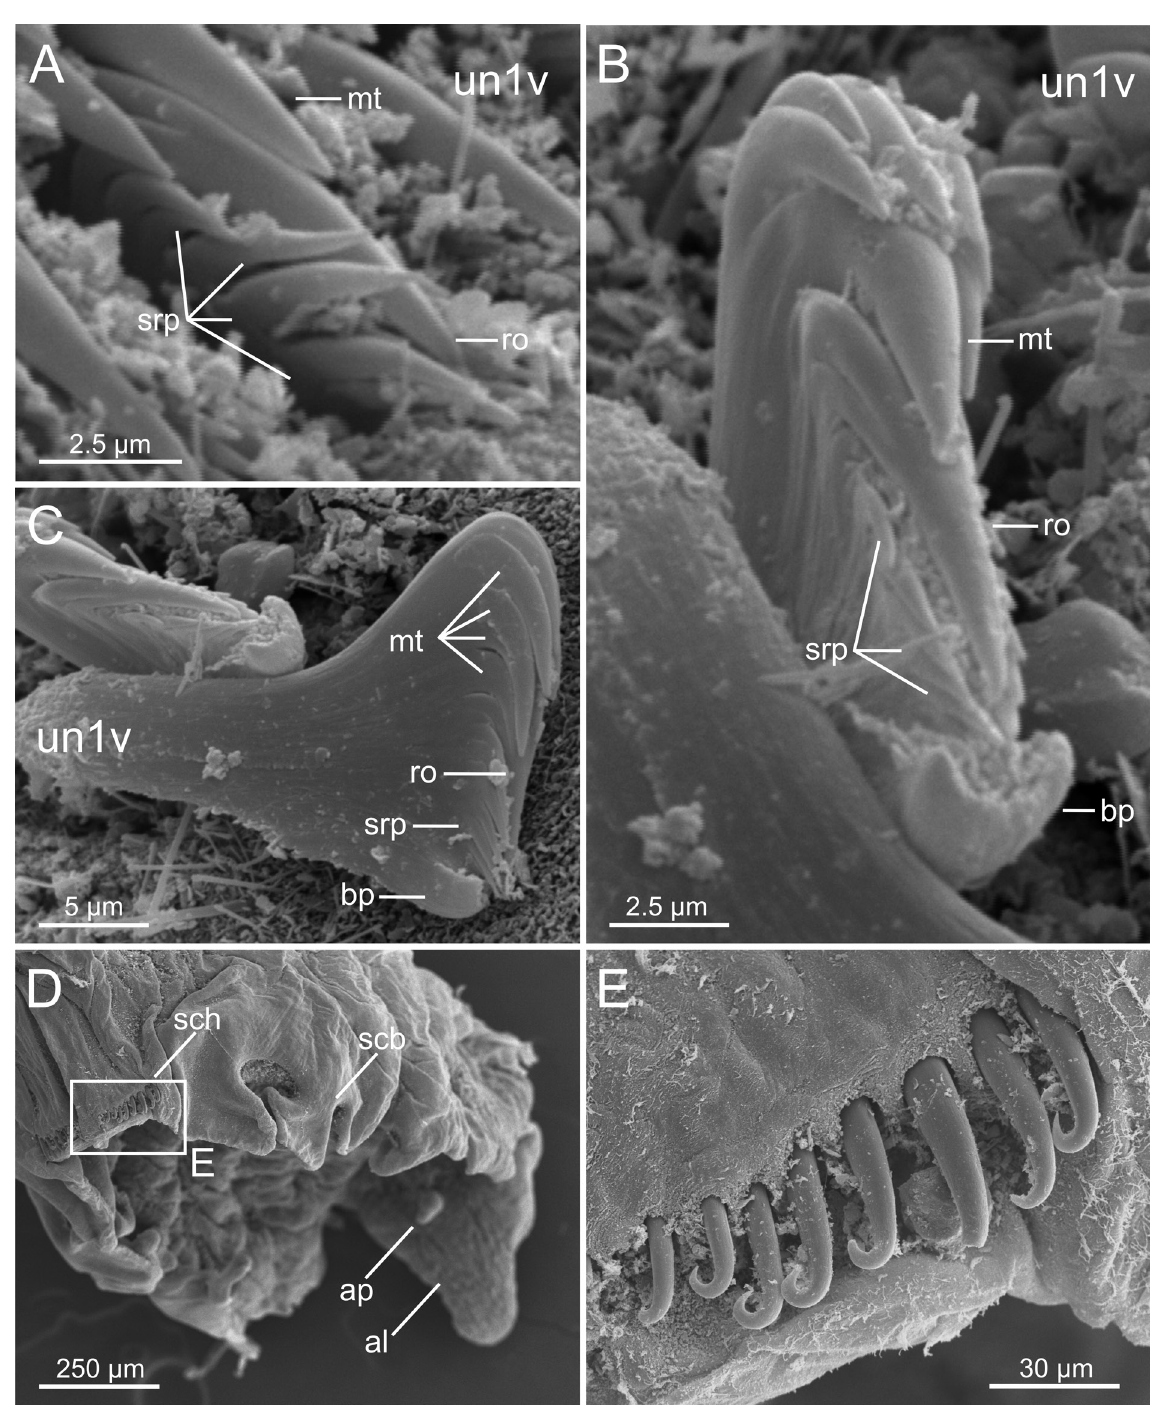
Fig. 6. Amphictene auricoma (O.F. Müller, 1776). SEM micrographs from a large specimen (BIOICE sample 2998, IINH-40213). A–C . Unciniger 1, ventral uncinus, frontolateral, frontal and lateral views, respectively. D . Scaphe. E . Scaphal hooks (framed in